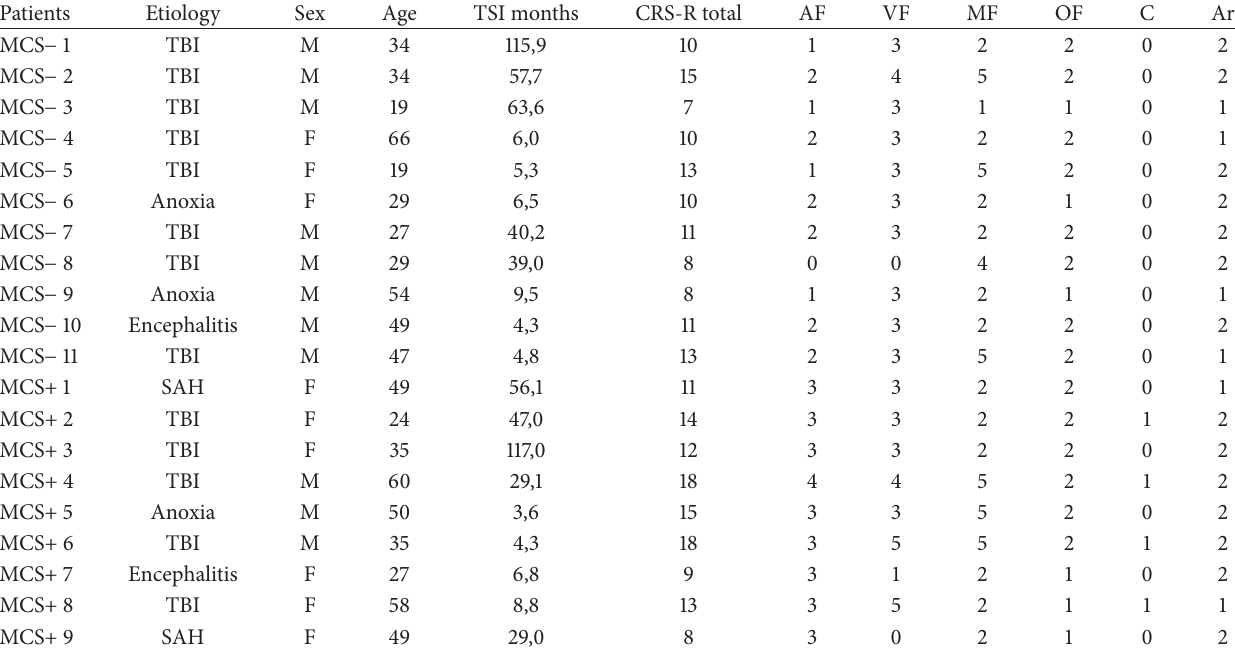
Table 1: Patients’ diagnosis, etiology, gender, age, time since injury, and CRS-R scores.